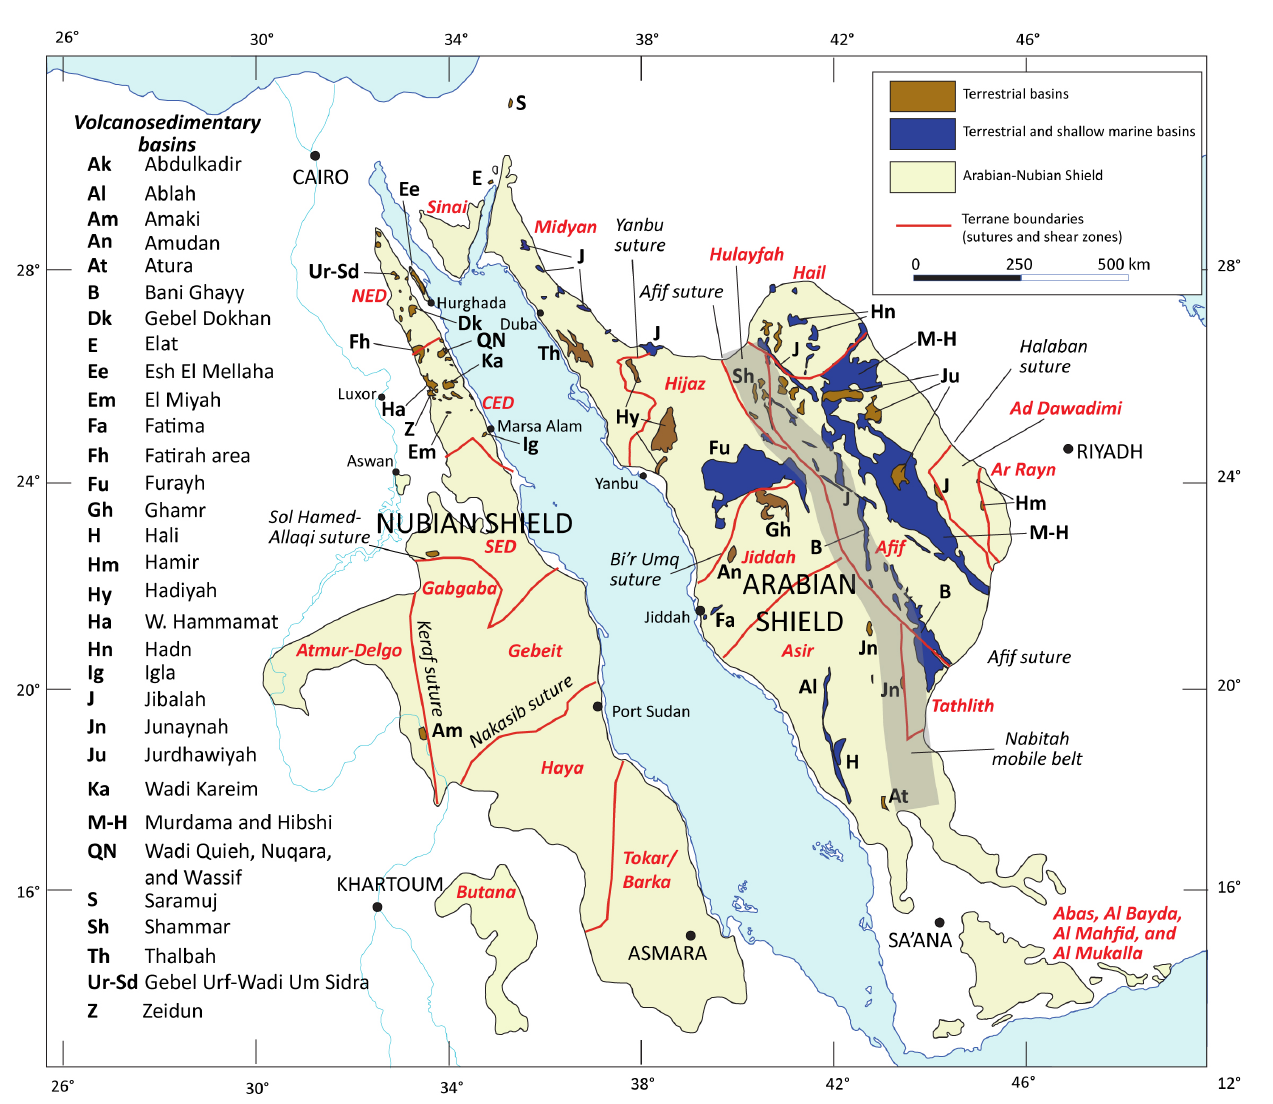
Figure 1. Volcanosedimentary basins in the Arabian-Nubian Shield unconformable on basement composed of older arc rocks and amalgamated terranes (terrane names in red italics). (After